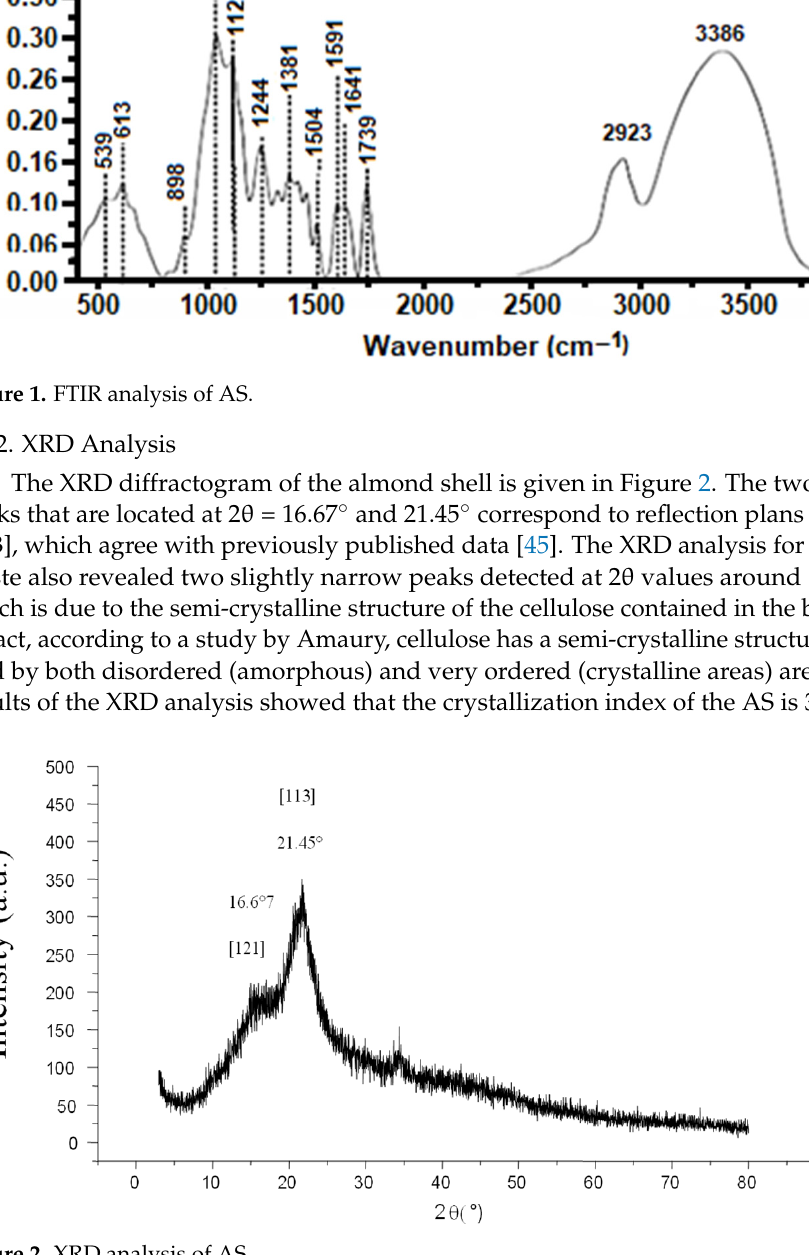
Figure 1. FTIR analysis of AS.